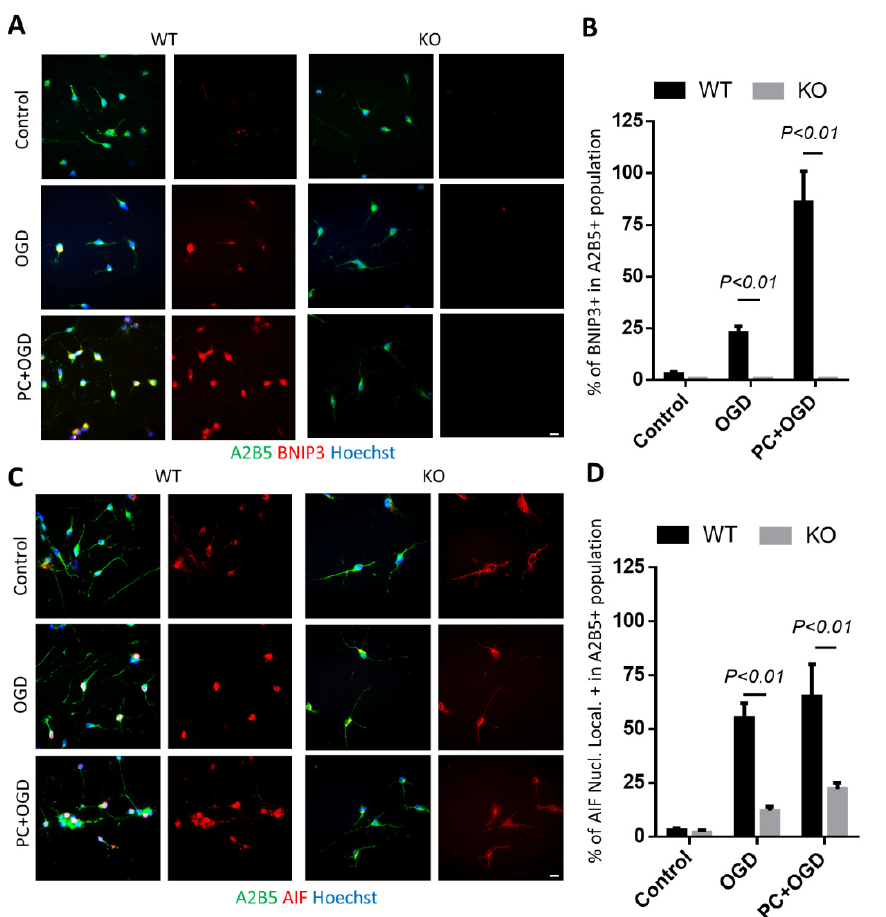
Figure 7. Knockout of BNIP3 ameliorates toxicity of preconditioning to OPCs. OPCs derived from WT/KO SVZ spheres were treated either with or without preconditioning, and then exposed to lethal OGD 24 h later. ( A ) Double-labeled immunostaining of A2B5 and BNIP3. ( B ) Quantification of the percentage of BNIP3+ cells in the A2B5+ population. ( C ) Double-labeled immunostaining of A2B5 and AIF (blue, nuclei; green, A2B5 and red, AIF); ( D ) Quantification of the percentage of AIF nucleus translocation in the A2B5 + population. Results shown represent mean ± SD from 3 independent experiments. Bar, 10 μ m.